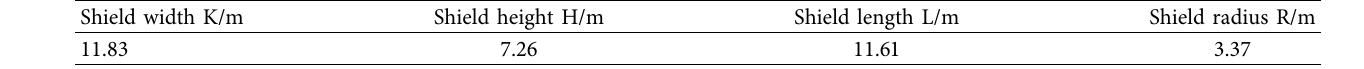
Table 1: The dimensions of the quasirectangle shield machine.